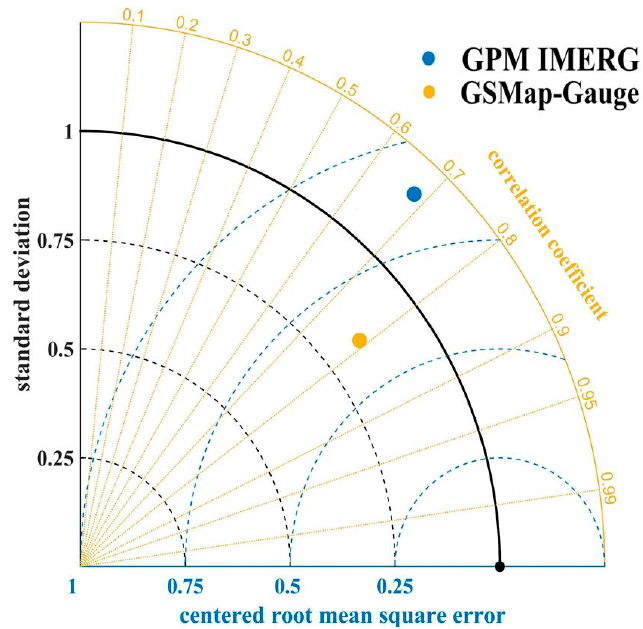
Figure 2. Taylor diagram for GPM IMERG versus GSMap ‐ Gauge.